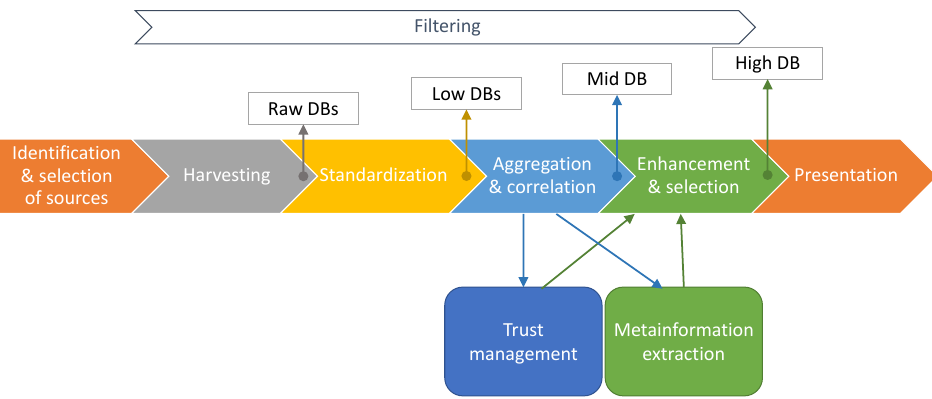
Figure 1. Stages and mechanisms to process information and